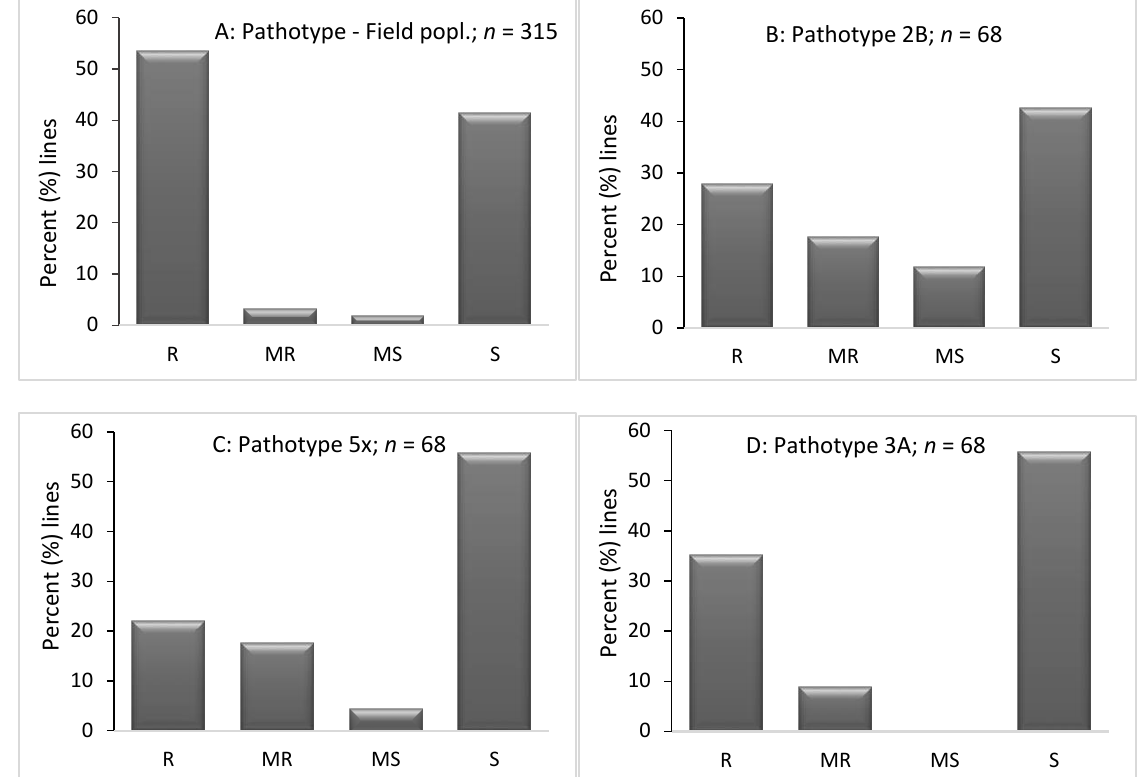
Figure 1. Cont E: Multiple Pathotypes; n = 68